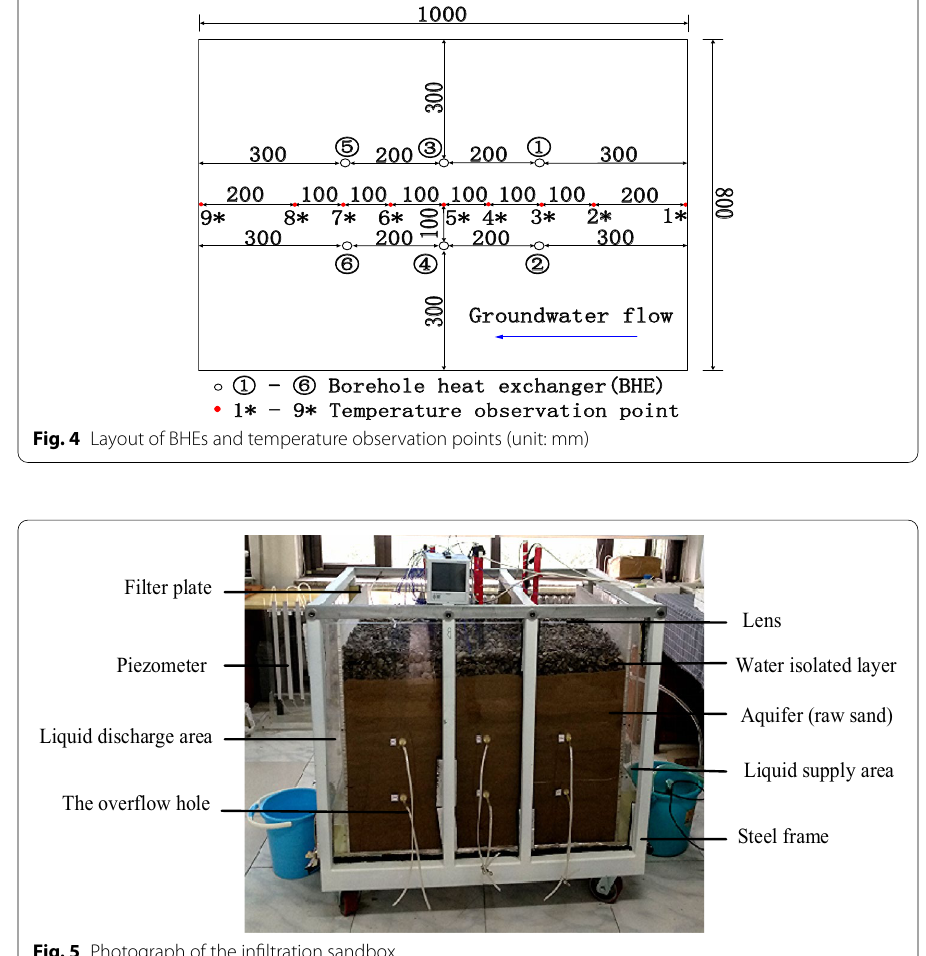
Experimental scheme